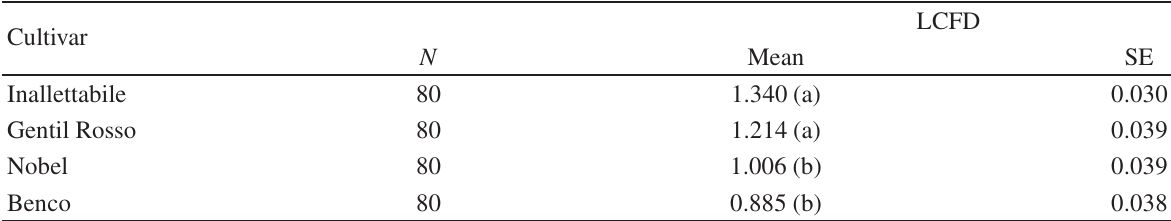
TABLE 2: Mean values of the local connected fractal dimension (LCFD) analysis of the images from the four analyzed wheat cultivars. Different letters indicate significant differences at P < 0 . 05